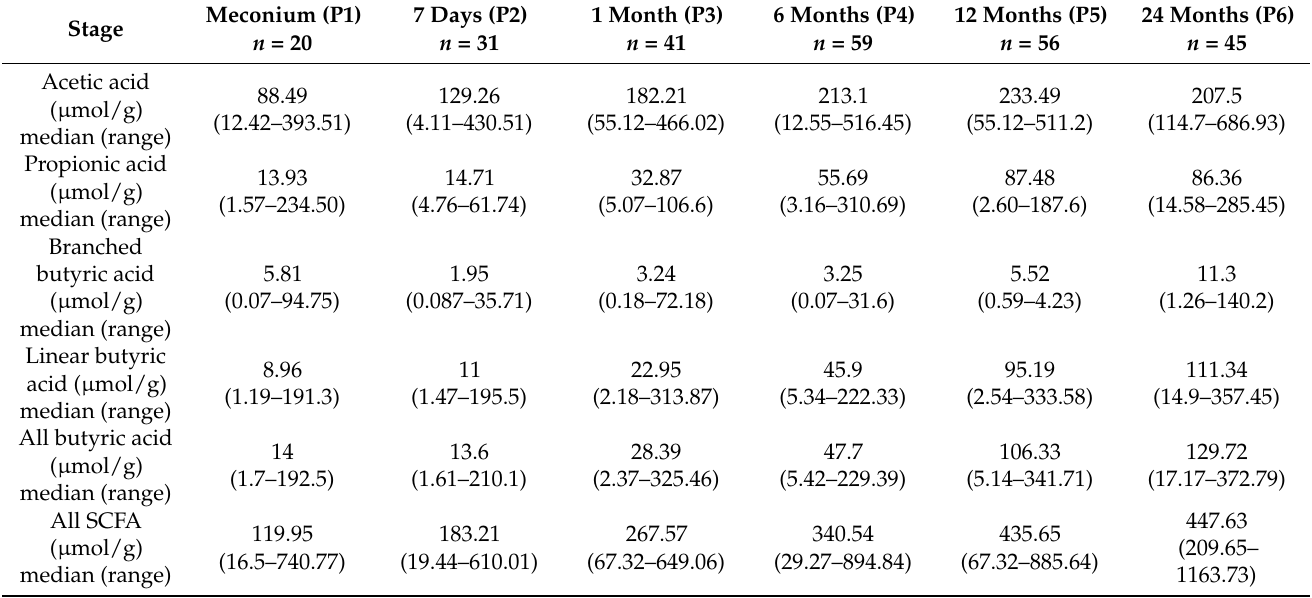
Table 3. Concentrations of SCFAs in children at six study time